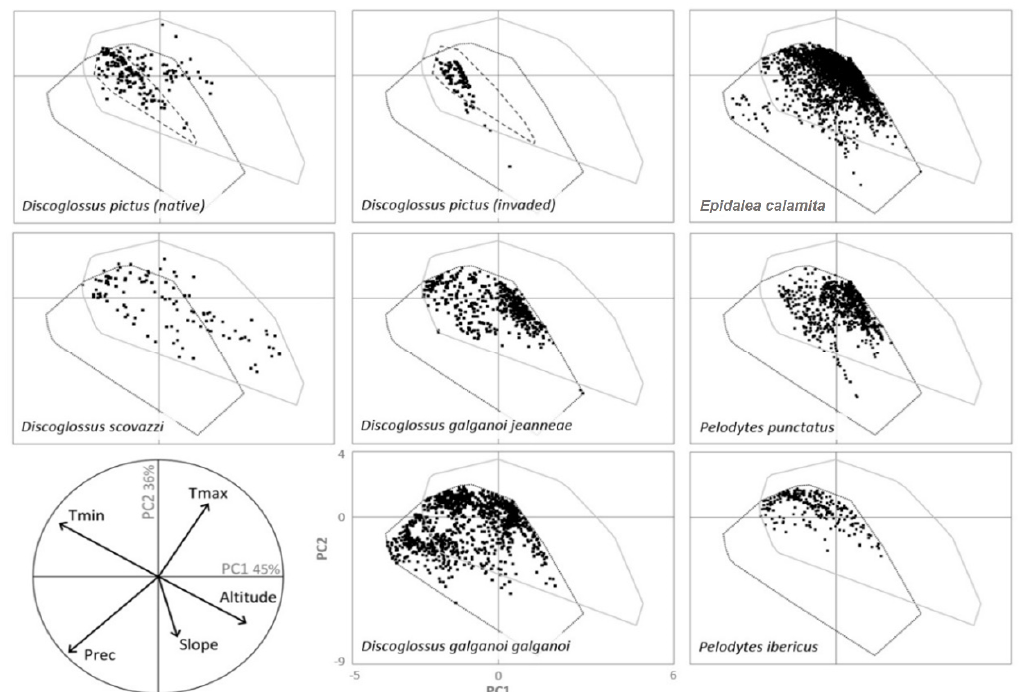
Figure 2. Environmental space of Discoglossus native and invaded (only D. pictus ) species ranges in a bivariate plot of two principal components. The convex hulls show the global climatic space in North Africa (solid grey), Iberian Peninsula, southern France (solid black), and Sicily (dashed black, only for D. pictus ). The correlation circle indicates the importance of each bioclimatic variable to the two principal axes of the Principal Components Analysis (PCA), which jointly explain 81% of the variance in the data.